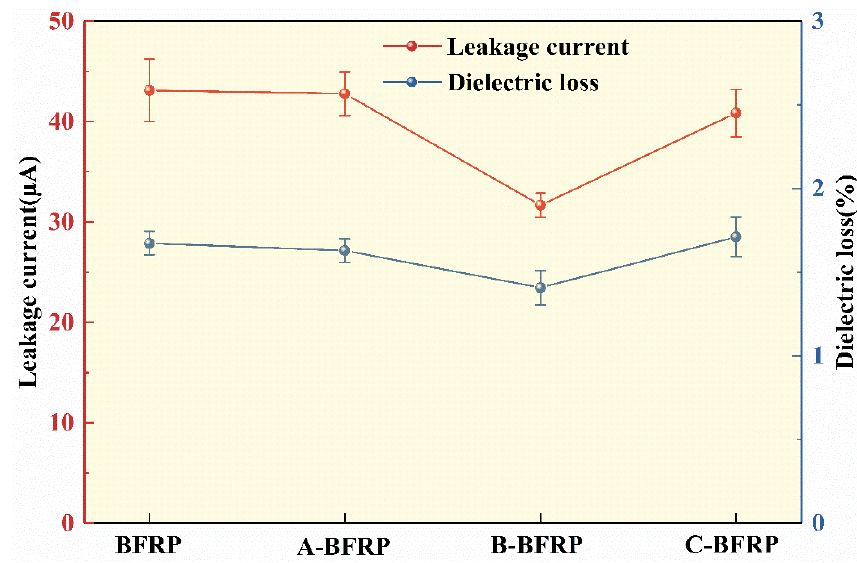
Figure 6. Leakage current and dielectric loss of basalt fiber/epoxy resin